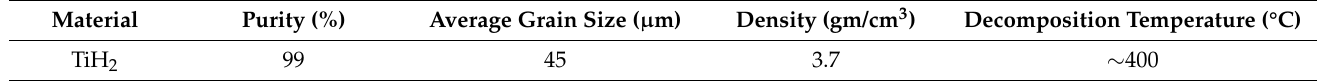
Table 3. Physical and chemical characteristics of TiH 2 powder.